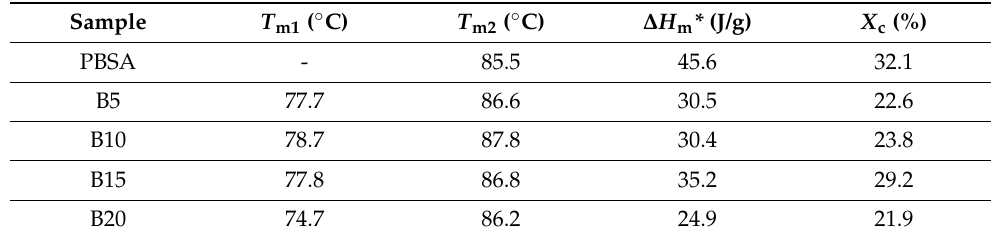
Figure 3. DSC thermograms of the PBSA and PBSA/B composites during the second heating scan at 10 °C/min. Table 1. The thermal parameters and crystallinity degree of the PBSA and PBSA/B composites. Δ H m * (J/g) values were normalized to the e ff ective PBSA content.